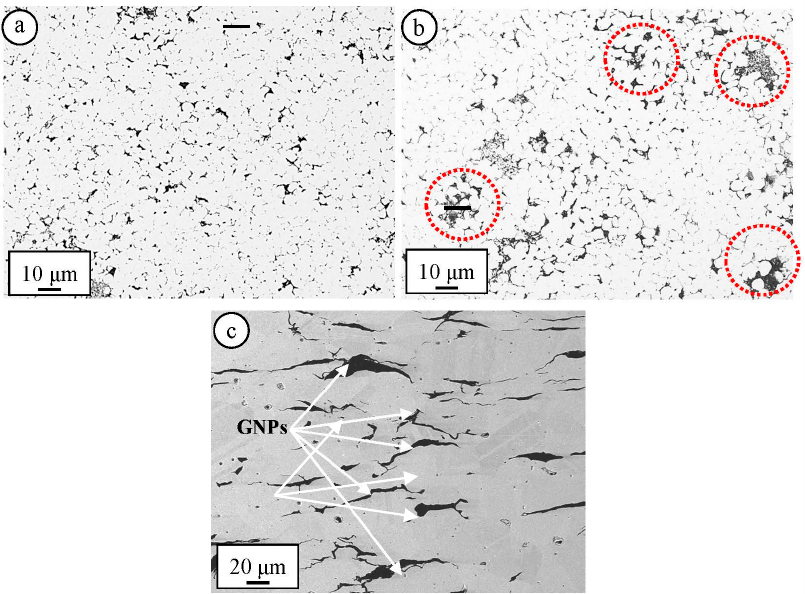
Figure 4. SEM images of sintered ( a ) Cu–4 vol % GNPs, ( b ) Cu–8 vol % GNPs parallel to the compaction direction, and ( c ) Cu–8 vol % GNPs perpendicular to the compaction direction.